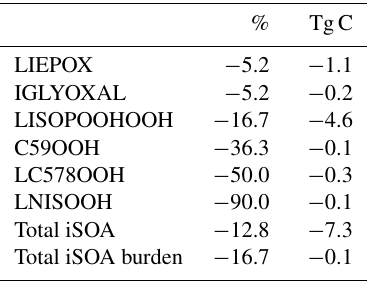
Table 6. Percentage changes in total iSOA formation in 2012 for the sensitivity run EVA using EVAPORATION instead of Nannoolal et al. (2008) to estimate the saturation vapor pressure and the evap- oration enthalpy of the isoprene-derived SOA